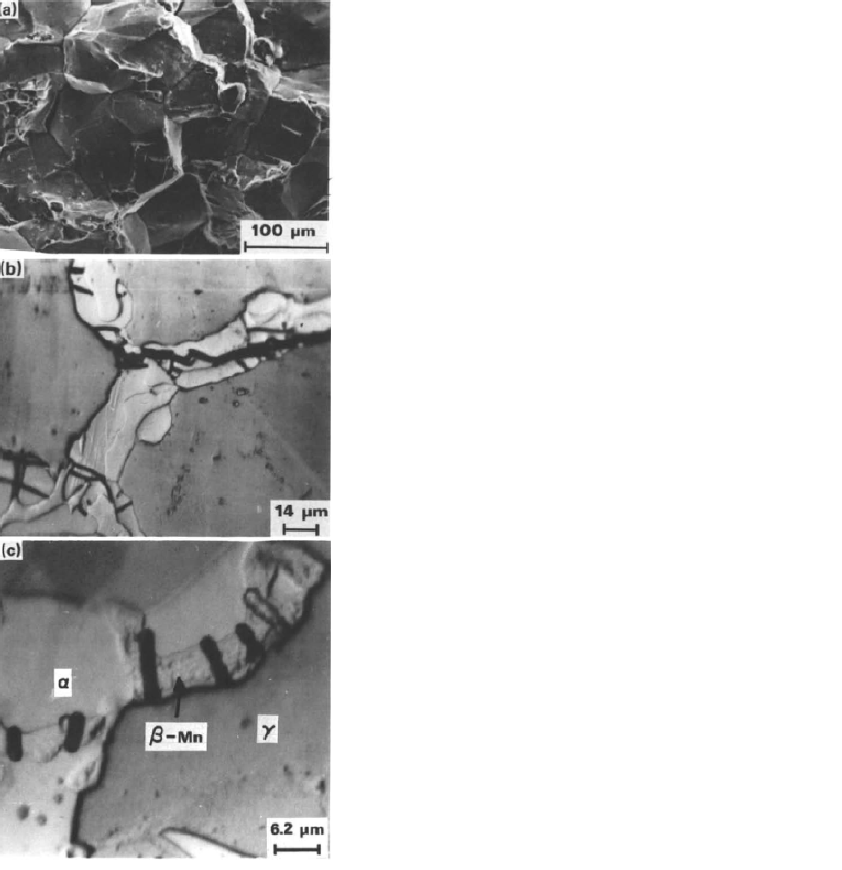
Figure 23. ( a ) SEM fractography of the Fe − 8.7A1 − 29.7Mn − 1.04C alloy (aged at 550 °C for 396 ks) after slow-rate straining in a 20% NaCl solution (100 °C) at the applied cathodic potential of − 0.800 V(Ag/AgCl); ( b ) optical micrograph of the longitudinal cross section of this aged alloy, which failed at − 0.800 V(Ag/AgCl); ( c ) a higher magnification of the SEM micrograph showing that the cracks originated from the β − Mn phase [147]. (Reproduced with permission from refs. [147]. Copyright (1986), Elsevier).